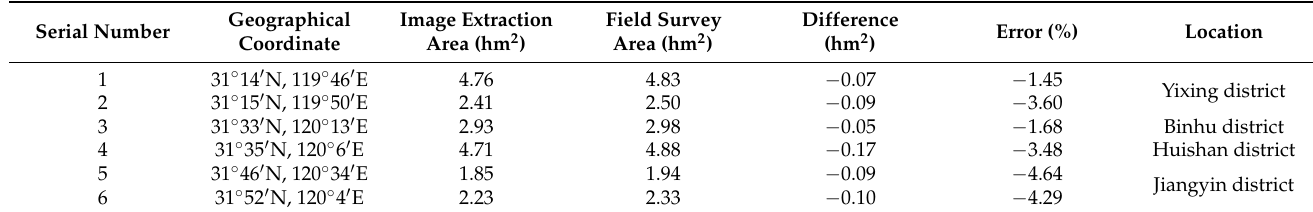
Table 5. Accuracy verification of remote sensing image extraction